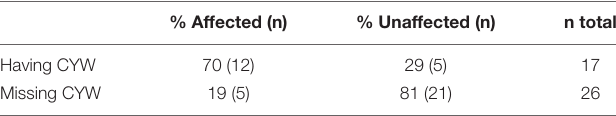
Results based on Supplementary Figure S8 and Supplementary Table S2